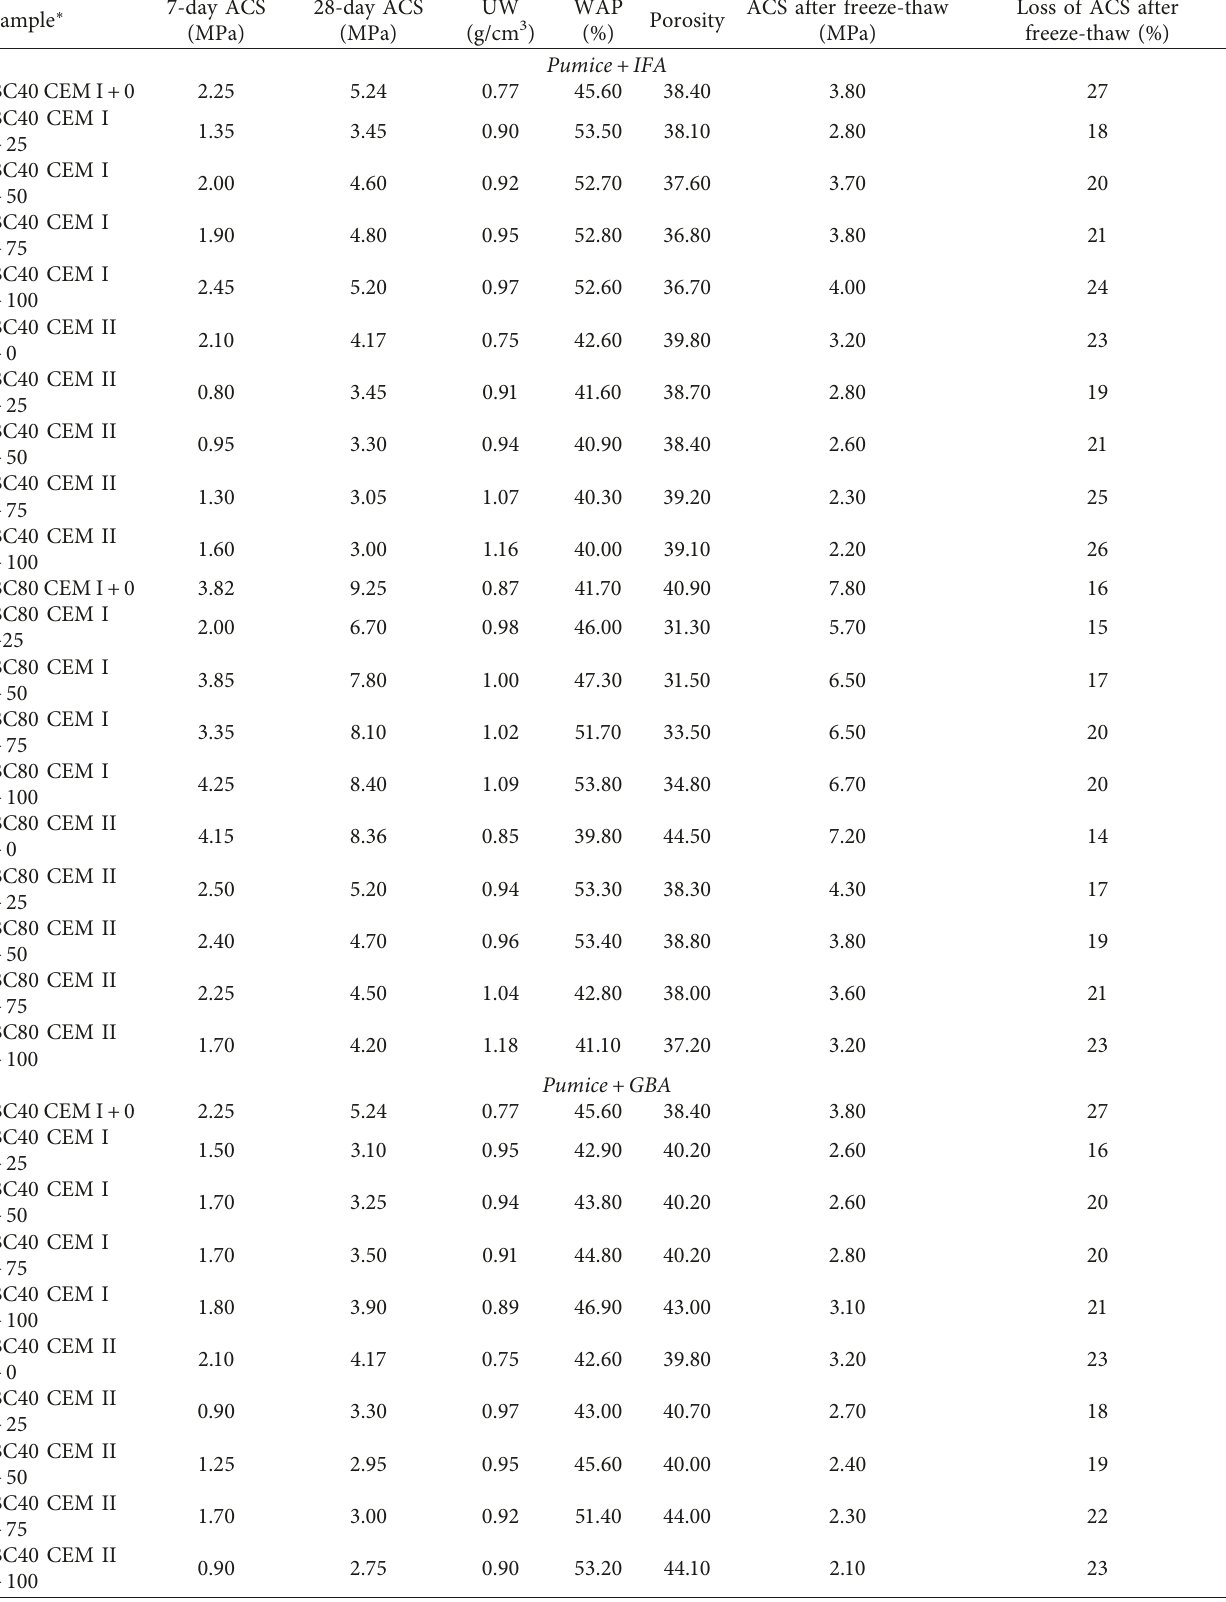
Table 2: Experimental results of pumice-based lightweight